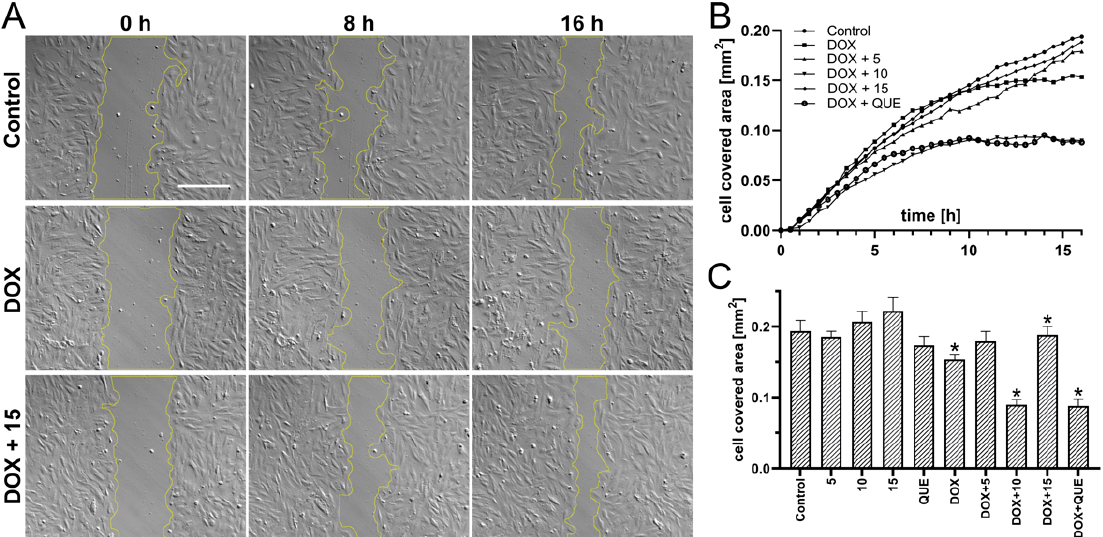
Figure 3. Effect of DOX in combination with compounds ( 5 , 10 , and 15 ) on the migration of rat cardiomyocytes in the wound-healing model. Cells were seeded at 1 × 10 5 per well in 12-well plates and cultivated overnight in order to achieve 100% confluence, in the presence of the examined compound (25 µM). Artificial wounds were made manually with a pipette tip, after which the culture medium was replaced with a fresh one containing additional DOX (0.5 µM). Representative images show the most significant results of the wound-healing assay in vitro at indicated time steps. The area of the wound is outlined in order to be measured. Scale bar is 300 µm ( A ). Graph presenting the dynamics of wound closure. The average cell-covered area from multiple fields of view is presented with 30-min time steps. Only the most relevant conditions are presented, in order to increase the transparency of the results ( B ). Complete summary of analyzed conditions. Each bar shows the average cell-covered area within the entire experiment (after 16 h of recording) ± SEM; n > 10; * p < 0.05; statistical significance was determined using the Brown–Forsythe and Welch’s ANOVA tests, along with a post-hoc unpaired t-test with Welch’s correction (where 5 , 10 , 15 , QUE, and DOX were compared to control, and DOX + 5, DOX + 10, DOX + 15, and DOX + QUE were compared to DOX) ( C ).